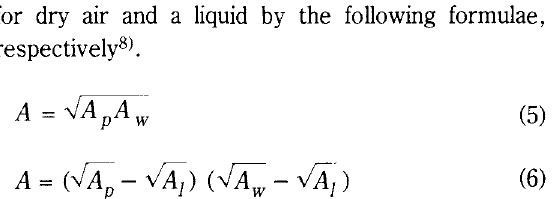
Fig. 8 Model showing water